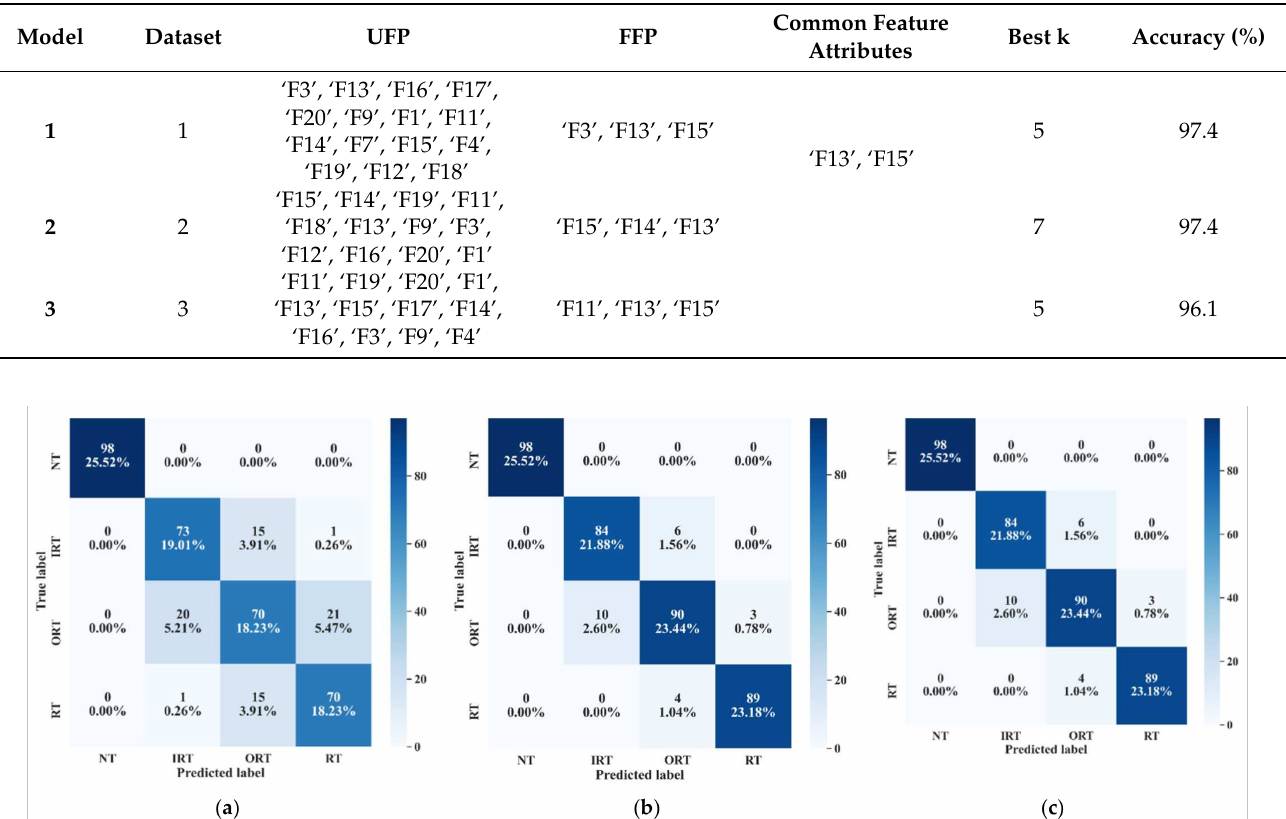
Table 9. Diagnostic performance of the proposed model.